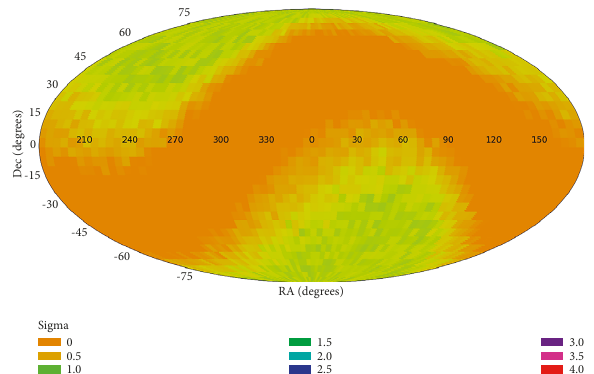
Figure 12: The χ 2 probability of the dipole axis when the galaxies are assigned with random spin directions.